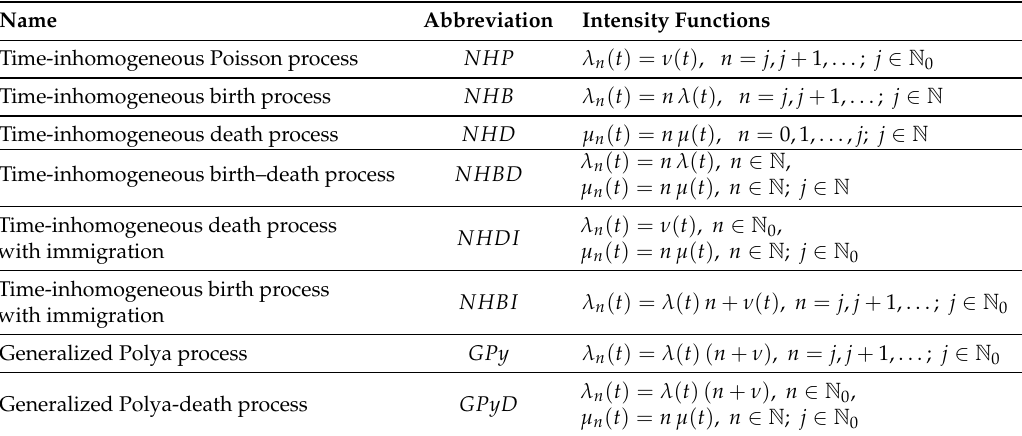
Table 1. Special time-inhomogeneous linear discrete processes conditioned to start from the state j